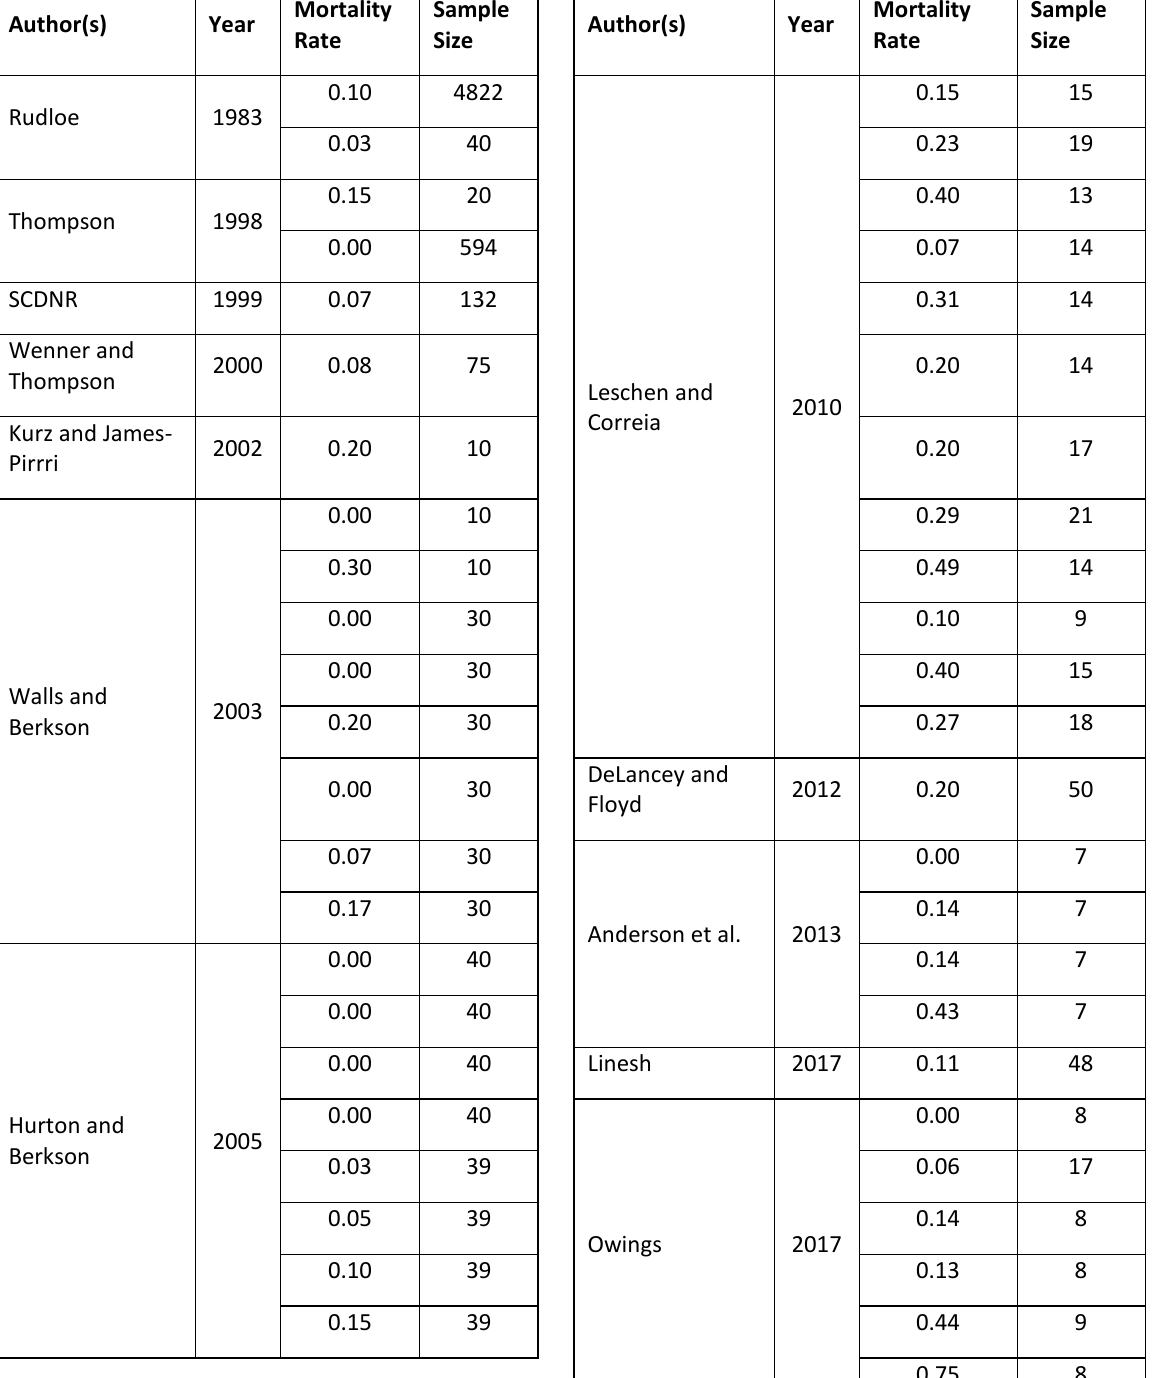
Table 16. Summary of studies that estimate a mortality rate of crabs bled for biomedical purposes and the same size of crabs bled to obtain the rate. See Appendix A for complete citations for each published